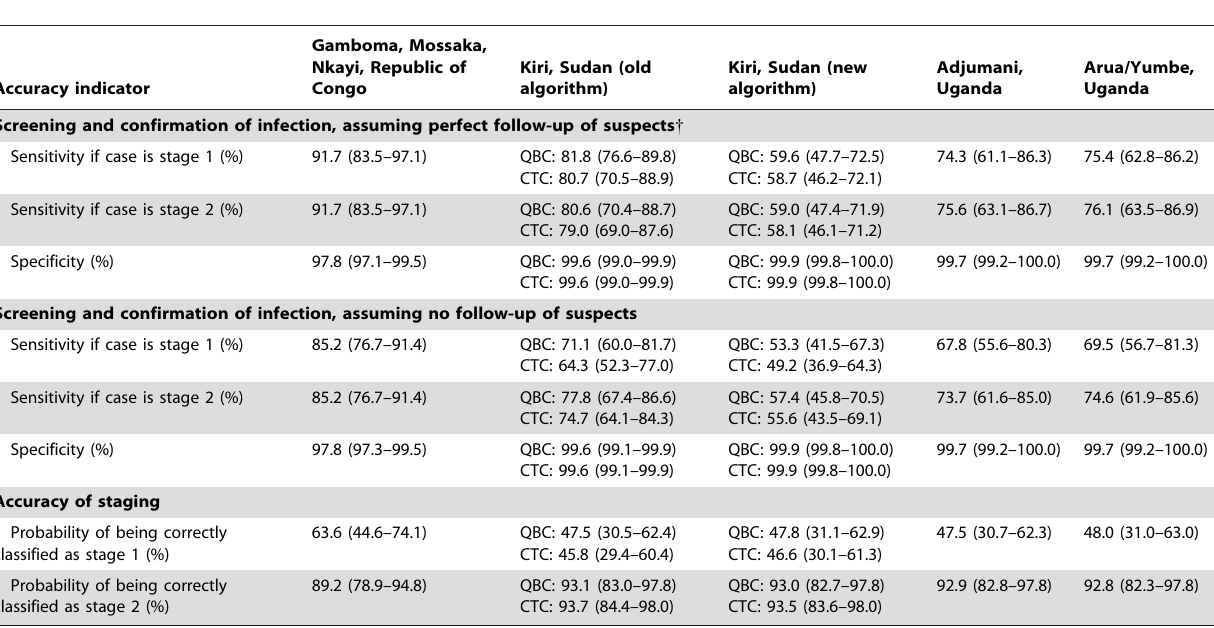
Table 5. Estimated sensitivity, specificity and accuracy of staging of HAT diagnostic algorithms (worst-case